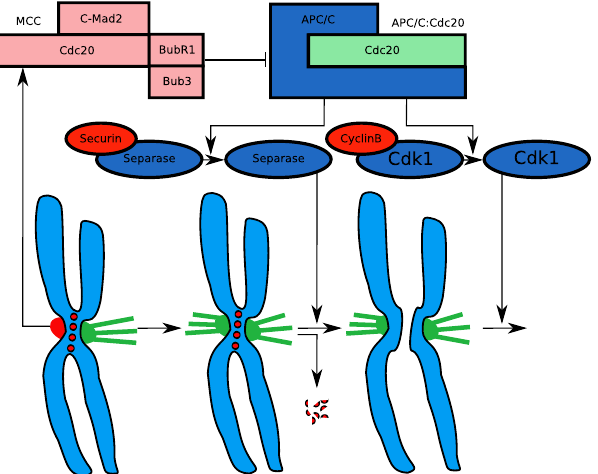
Figure 1. Schematic illustration of SAC activity. Unattached kinetochores (red in the middle of the chromosomes) catalyze the formation of MCC which inhibits the Cdc20-activated APC/C. Once all kinetochores are attached (green) the APC/C ubiquitinates Securin and CyclinB, resulting in the destruction of Cohesin by Separase. Unblocked Cdk1 initiates metaphase and progress in the cell